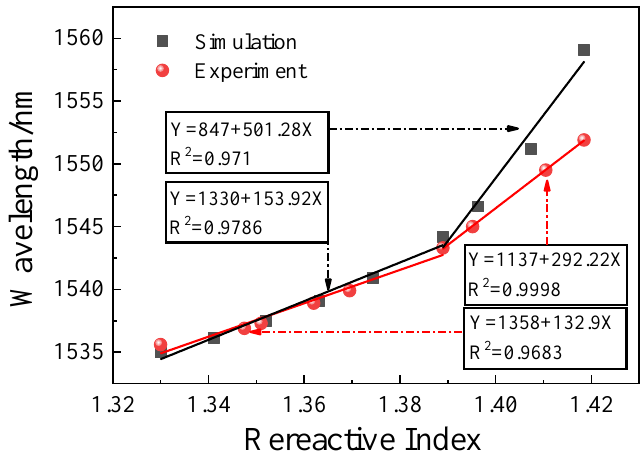
Figure 7. The sensitivity and linearity of the wavelength with varying RI (simulation and experiment).